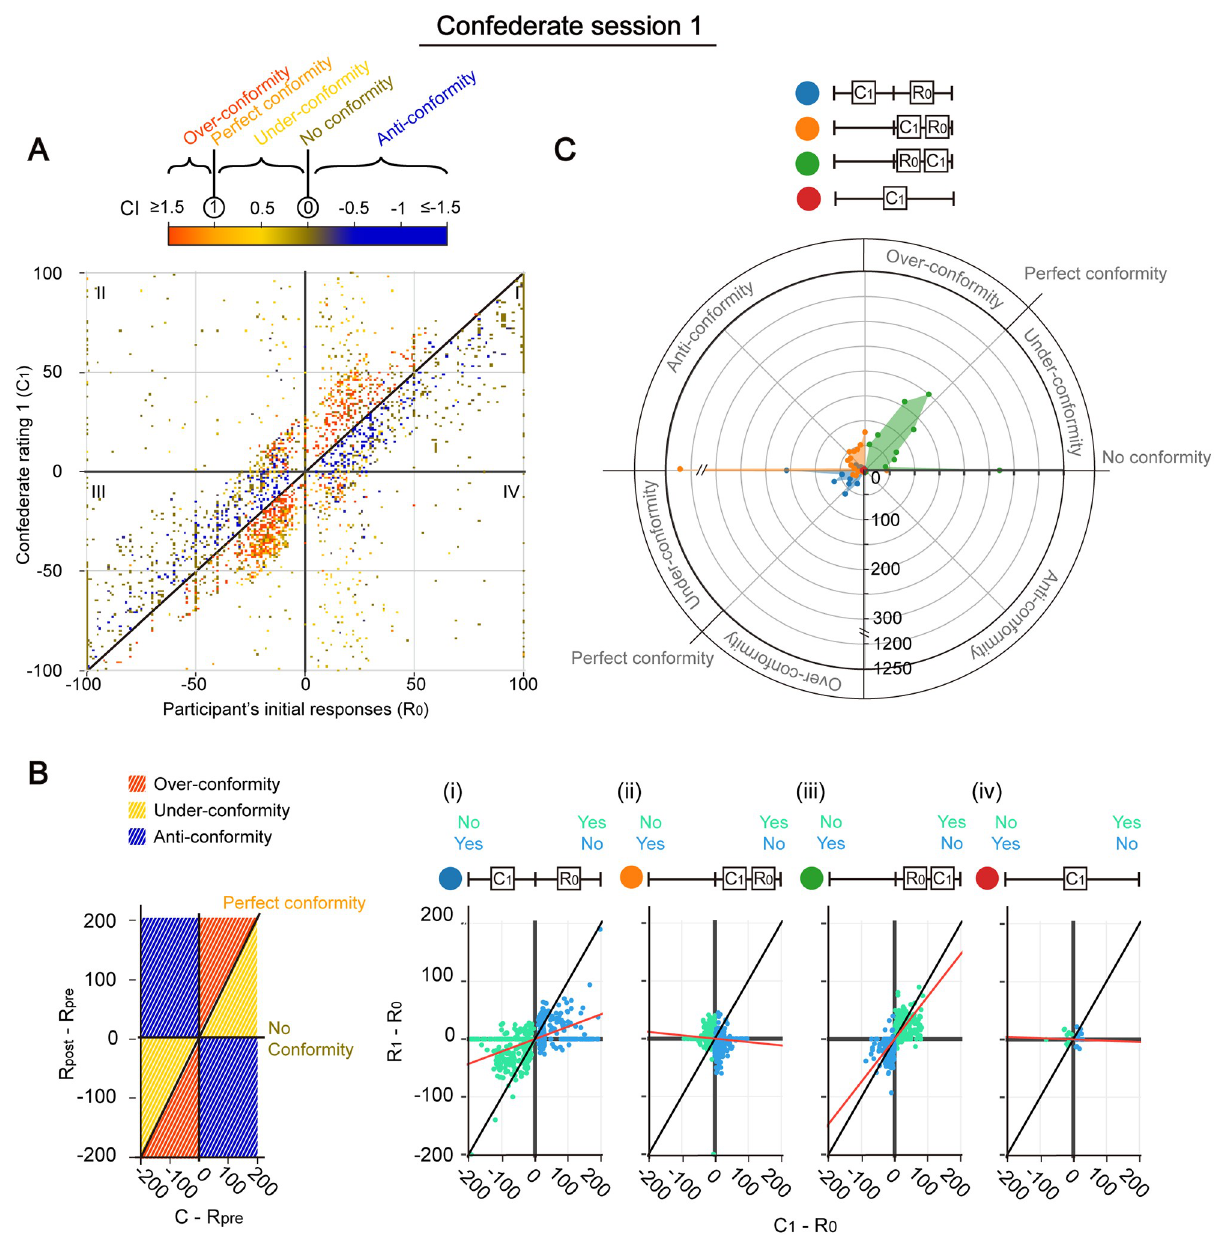
Fig 3. Conforming behaviours with respect to R 0 and confederate confidence in session 1. (A) Plot of confederate value (C 1 ) against participant’s initial responses (R 0 ). Each dot represents a subject-video, with colour representing the conformity index (CI). Black diagonal line is R 0 = C 1 . n = 3345. Data points with invalid CI (e.g., when R 0 = C 1 ) were excluded. (B) Plot of change in response (R 1 − R 0 ) against the difference between C 1 and R 0 . Left panel, schematic diagram depicting the different conformity types (coloured as in Fig 3A) mapped onto each zones and lines. Right panels, actual data, grouped based on the relationship between R 0 and C 1 : column 1, C 1 being on the opposite side of R 0 ; columns 2, C 1 remains on the same side but being less or equally confident to R 0 ; columns 3, C 1 remains on the same side but being more confident than R 0 ; column 4, C 1 = 0. Data in green are with R 0 � 0 whereas data in blue are with R 0 < 0, also schematized by a flipped slider in the symbols above. Red lines are the best fit lines, with the slope reflecting the average CI, of all the points on the graph. R 0 = 0 and datapoints with invalid CI were excluded, n = 3360. (C) Radial histogram showing the number of participant-videos with different ranges of CI. Quadrants are arranged as in (B), with the types of conformity behaviour reiterated on the outer circle. Participant-video counts (see labelled axis) were obtained by mapping the data points in (B) on a polar coordinate and by binning together data points that fell within 10-degree angular intervals to more clearly illustrate the distribution. Data with R 0 � 0 [green points in (B)] and R 0 < 0 [blue points in (B)] were combined by reflecting the latter over origin (i.e., flipping ratings over to the opposite side on the slide